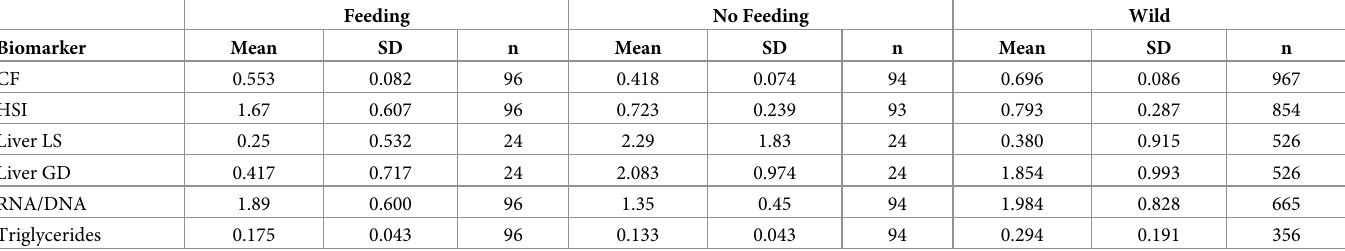
Table 3. Comparison of wild Delta Smelt to hatchery Delta Smelt from the Feeding and No Feeding treatments. For the hatchery fish, means were calculated across Day 21–56 (i.e., 21 days is the point where starvation induced mortality was first apparent, Fig 2). Feeding No Feeding Wild